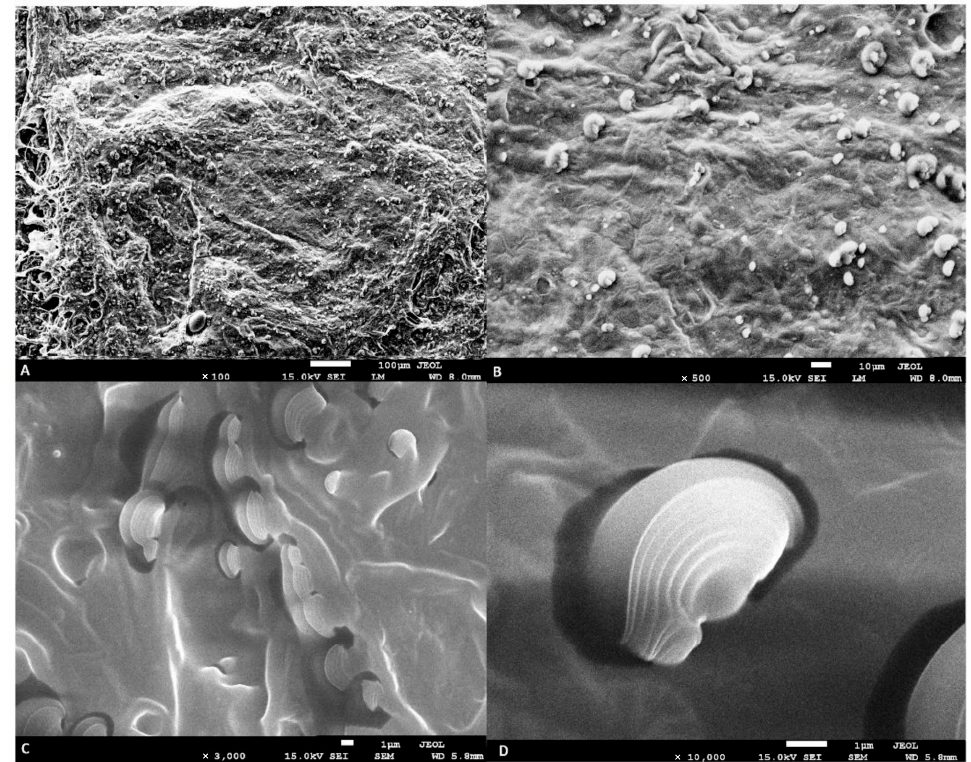
Figure 1. SEM analysis of freeze-dried emulsion hydrogels with encapsulated açai oil (31%), ( A , B )—dis- tribution of nanocapsules; ( C , D )—multilayer